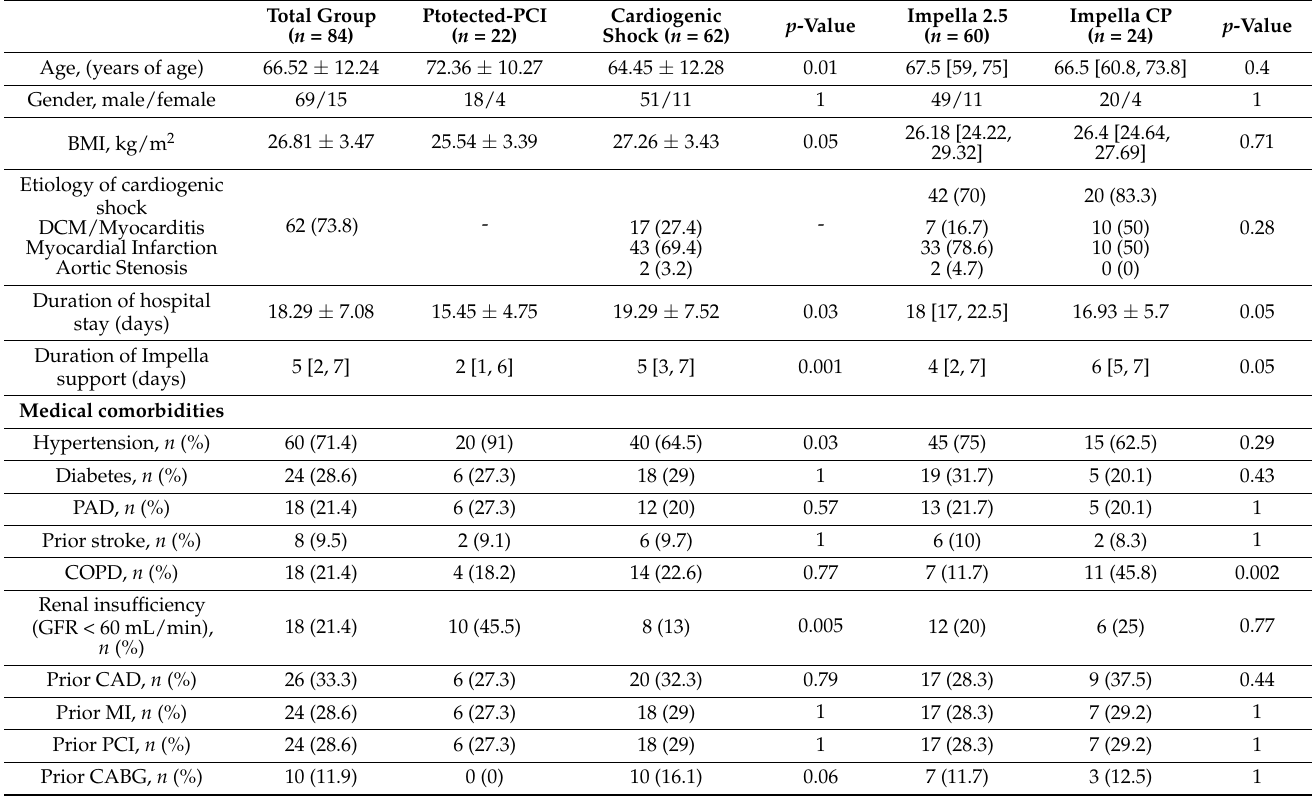
Table 1. Demographics and baseline characteristics of the study population.